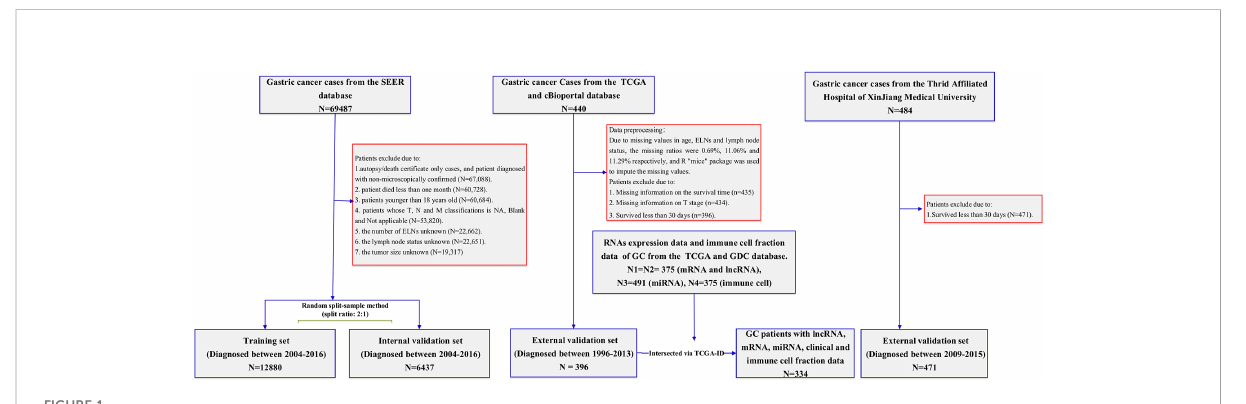
FIGURE 1 Flowchart illustrating gastric cancer patient selection for this